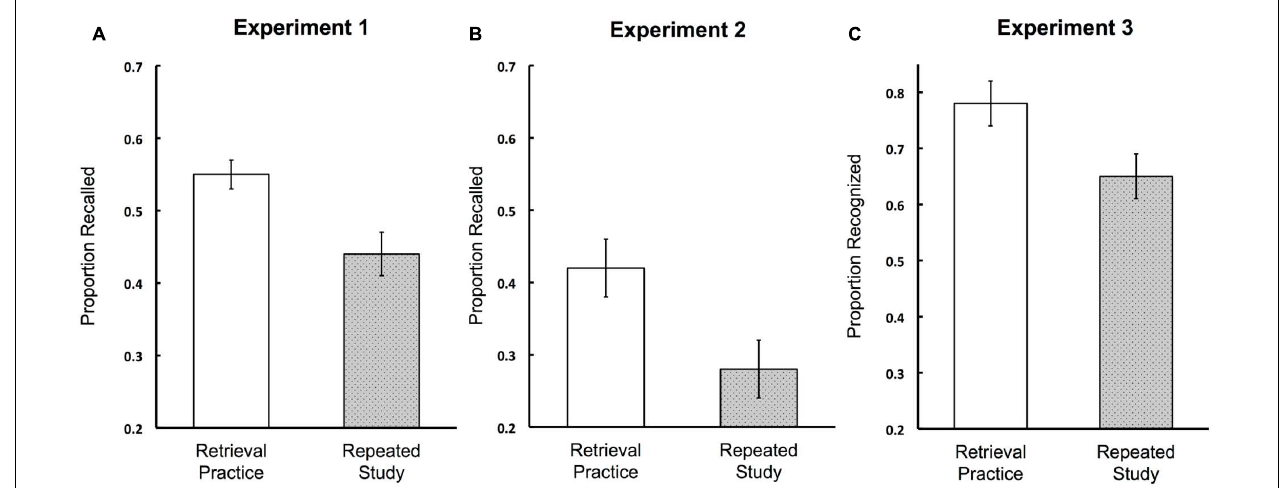
FIGURE 1 | Proportion of target words recalled on the final free recall test in Experiment 1 (A) and Experiment 2 (B), and proportion of target words correctly recognized in Experiment 3 (C). Error bars represent standard error of the mean. Note that the scale is different in (C) than it is in (A) and (B) . In all three experiments, children recalled and recognized more words on the final test when they practiced retrieving the words relative to when they repeatedly studied